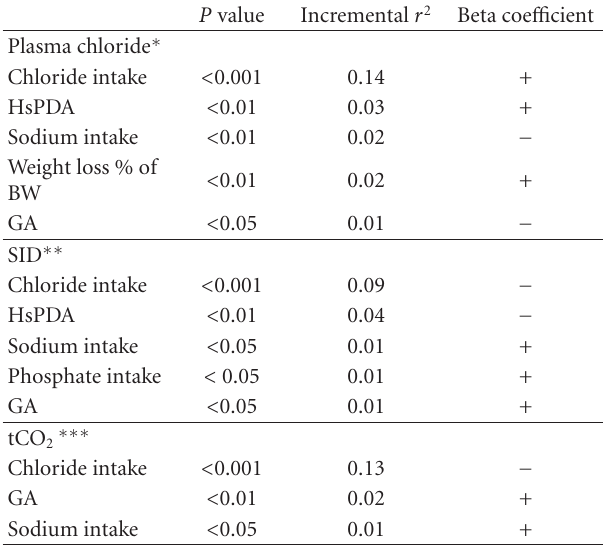
Table 2: Factors associated with plasma chloride (mmol/L), SID, and tCO 2 levels (mmol/L) at multivariate analysis in 107 infants < 33 weeks of